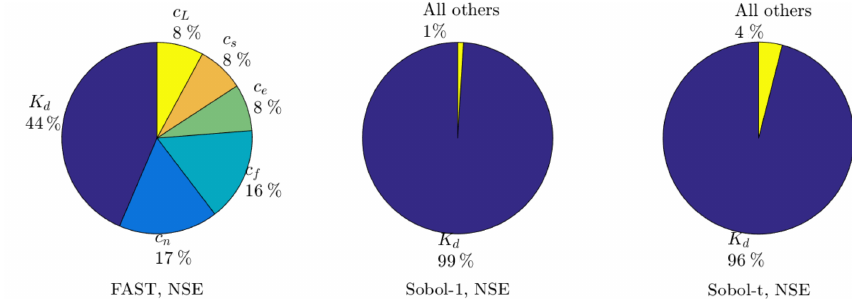
Figure 6. First- and total-order effects indicating the sensitivity of the model parameters on model performance. First-order effects ac- count for parameters independently whereas second-order effects take include possible correlations between parameters. First-order effects were computed with the FAST and Sobol-1 methods. Second-order effects were computed using the Sobol- t method. The Nash–Sutcliffe performance was used to evaluate the